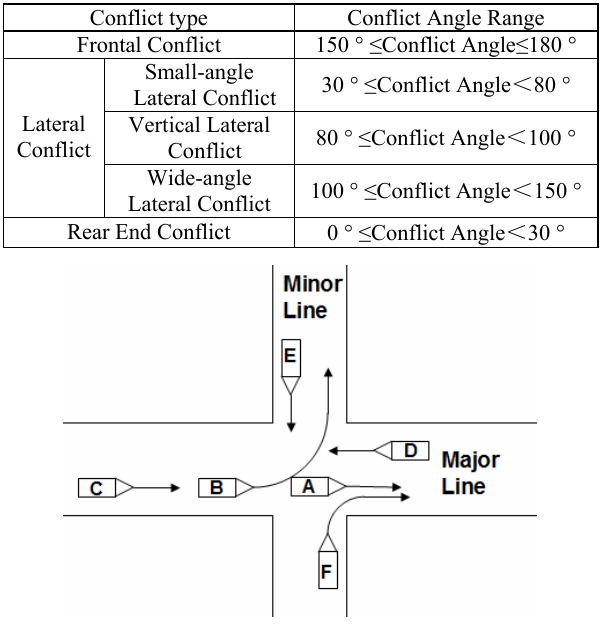
Fig.2. Conflict Types in Unsignalized